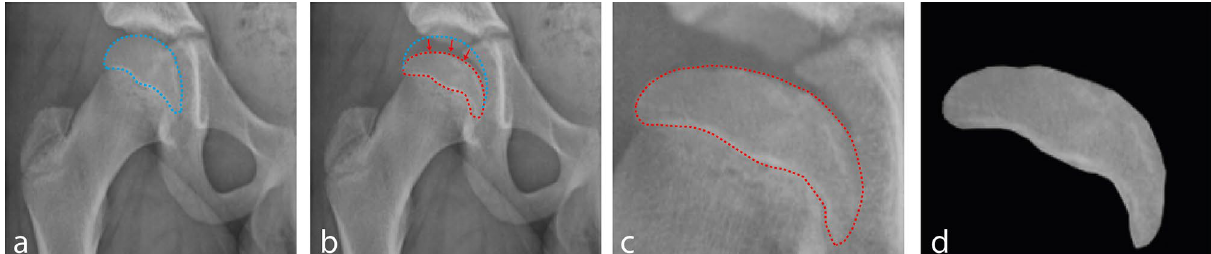
Figure 2. An illustration of how to produce a class B femoral head ( a ) Normal hip radiograph with a blue line encircling the femoral head ( b ) The height of the lateral column of the normal femoral head was reduced up to 50%. The head has been converted to group B. ( c ) The newly created head is highlighted in red. ( d ) The highlighted head is segmented from the image and assigned as the final training data.